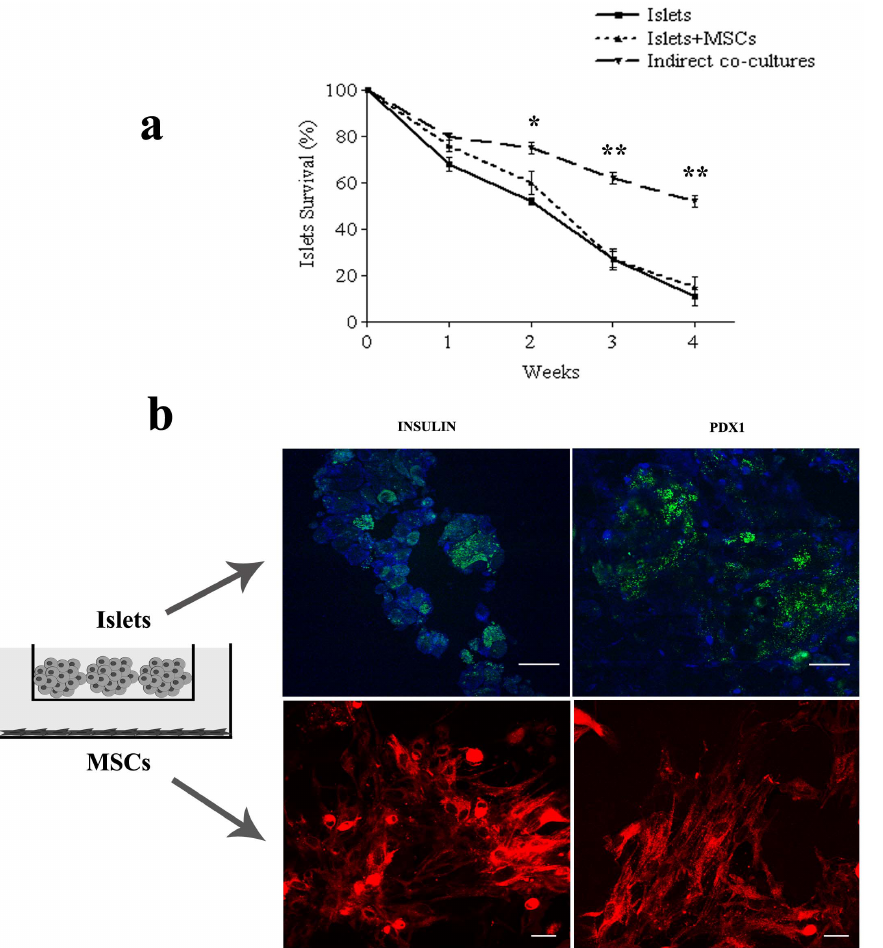
Figure 5. Indirect co-cultures. Survival percentage evaluation of pancreatic islets indirectly co-cultured with MSCs. Calcein-positive pancreatic islets were counted and survival percentage was calculated up to 4 weeks of culture. Results are expressed as mean 6 SD of three independent experiments * P , 0.01 Indirect co-cultures vs Islets, ** P , 0.001 Indirect co-cultures vs Islets and Indirect co-cultures vs Islets + MSCs. Insulin and Pdx1 positive cells in indirect co-cultures made up by pancreatic islets (within the Transwell, upper panel), and MSCs adherent to the cover glass (lower panel). In green, calcein positive pancreatic islets. In red, MSCs stained with DiI. In blue, insulin or Pdx1 positive cells. Bar 30 m m.